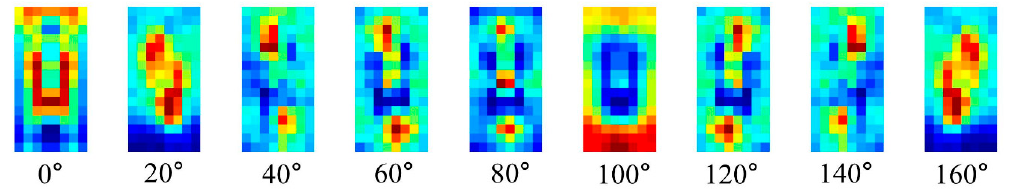
Figure 3. Example of IR image and its T channel.